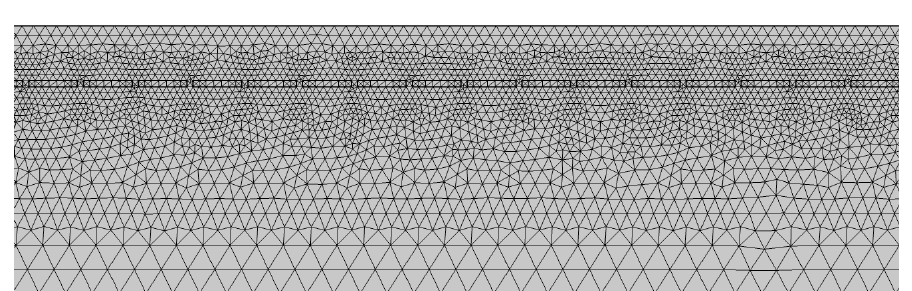
Figure 11. Nanoantenna model and its mesh representation.